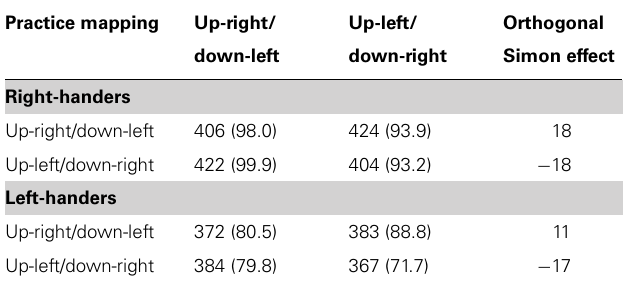
Table 2 | Experiment